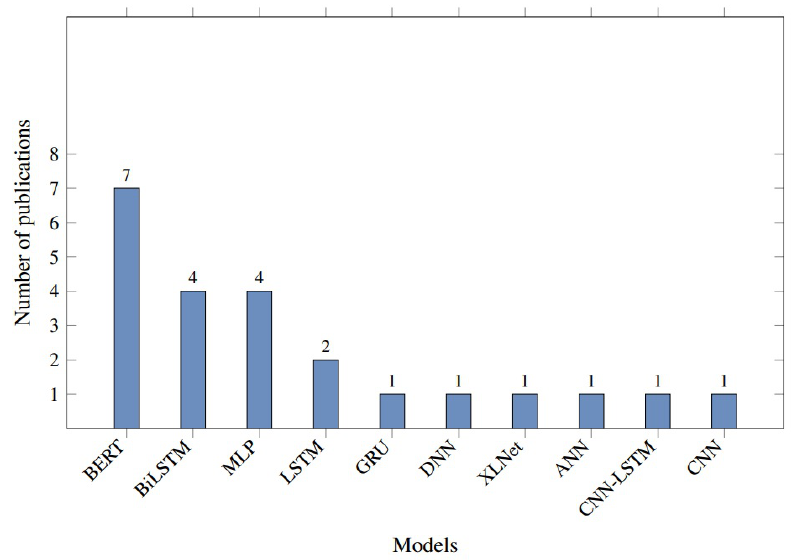
Figure 3. Distribution of deep learning sentiment classifiers used in learning-based